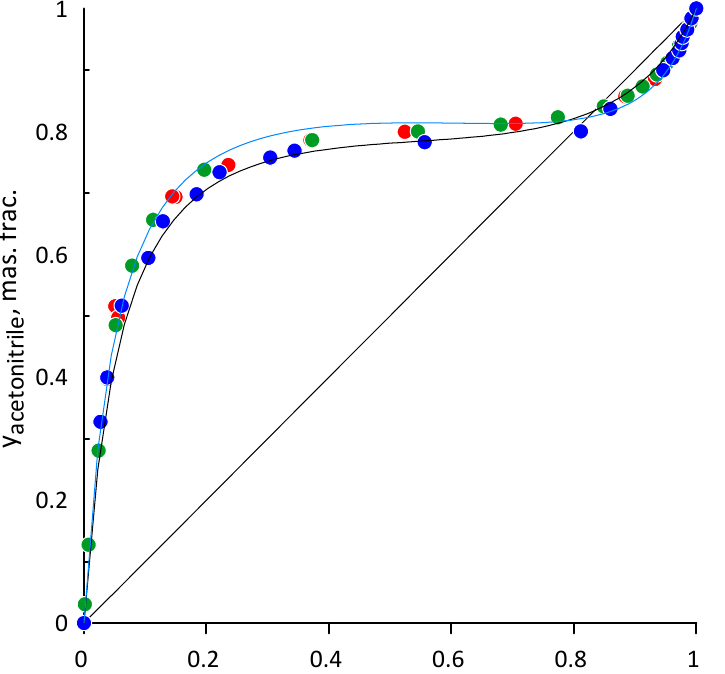
Figure 5. YX diagram for a binary mixture of acetonitrile–water at atmospheric pressure. Green circles—[53], blue circles—[54], red circles—experimental data, black line—calculated by the UNIFAC model with corrected parameters, blue line—calculated by the UNIFAC model [55].